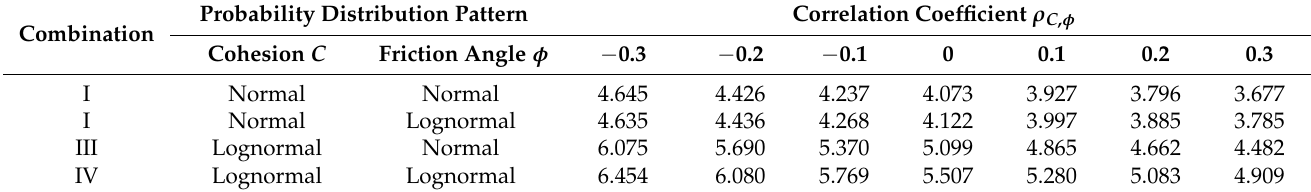
Table 4. Slope reliability with different probability distribution patterns and correlation coefficients. Probability Distribution Pattern Combination